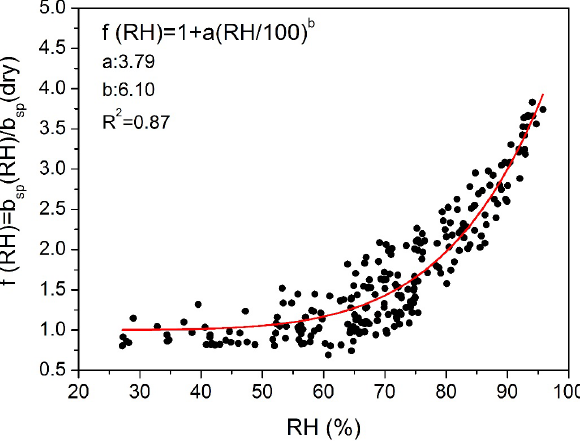
Figure 14. Hygroscopic growth for aerosol scattering f ( RH ) as a function of RH with curve fitting. Scattered dots are the measured f ( RH ) values, and the line is the empirical fitting curve.